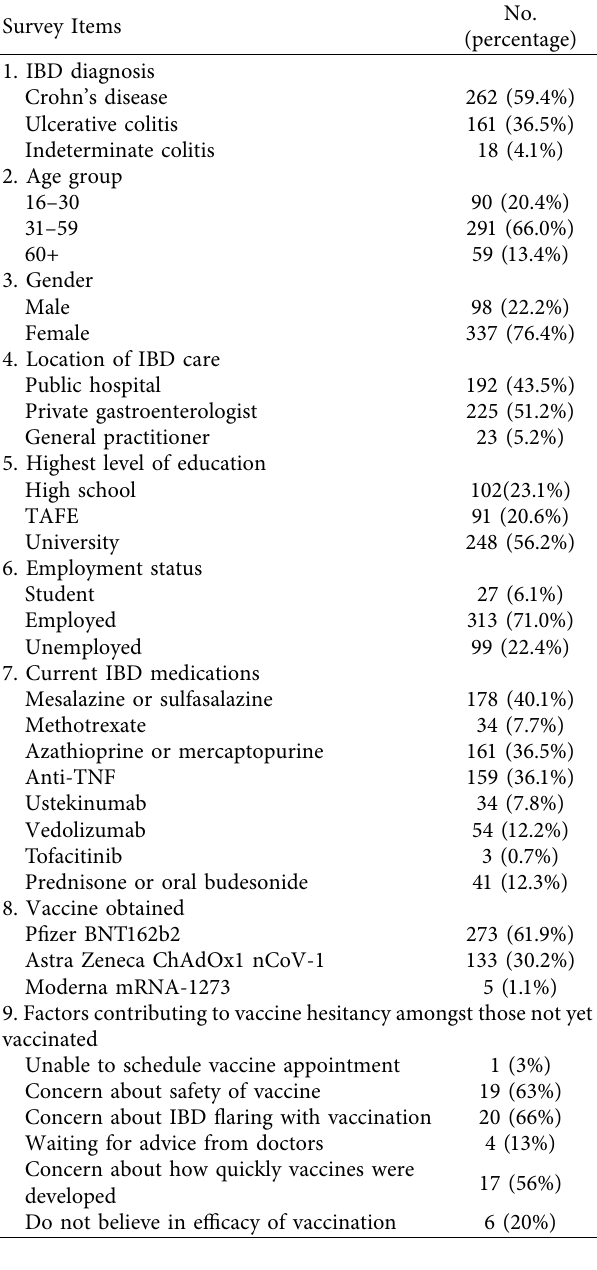
Table 1: Respondent